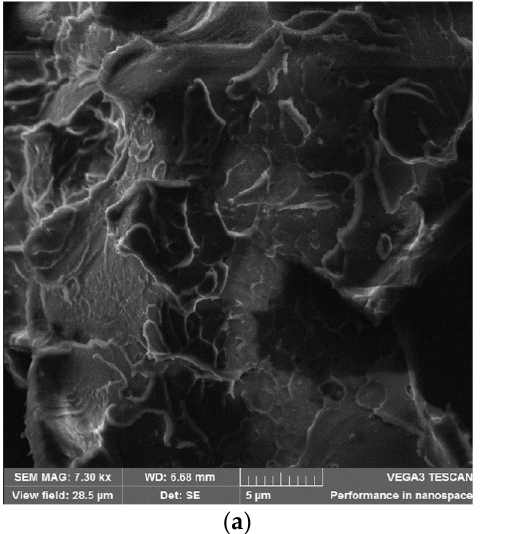
Figure 8. Scanning electron microscope (SEM) images of the broken surface of carbon-filled samples: